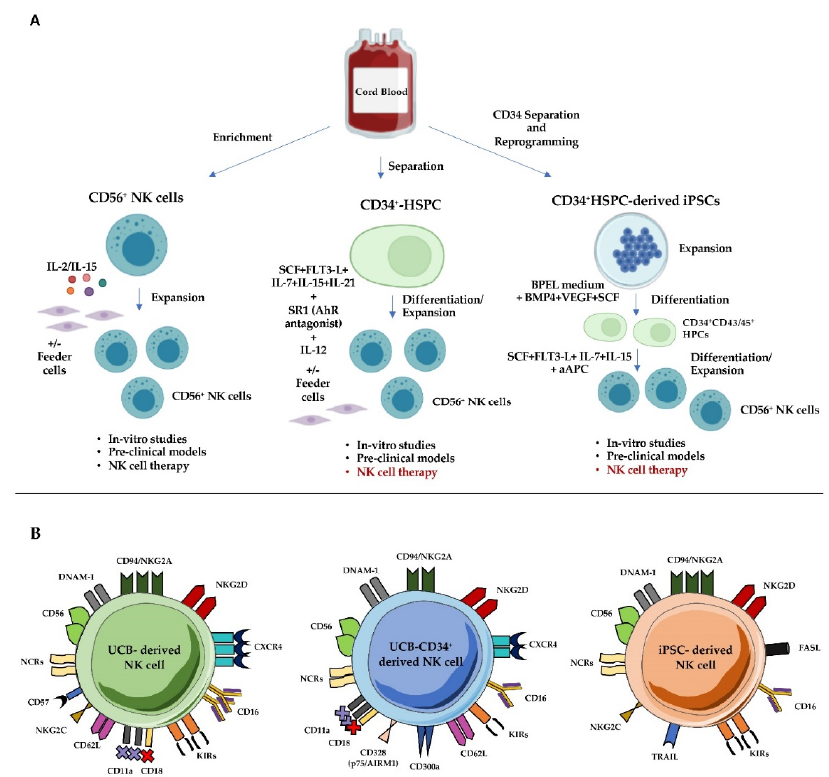
Figure 1. UCB as a source of NK cells. Panel ( A ). Overview of methods to generate, enrich and expand NK cells from UCB. Purified mature NK cells can be obtained directly from UCB and in-vitro expanded in the presence of IL-12 and IL-15 and feeder cells (e.g., K562, 721.221 cell lines). NK cells can also be differentiated from CD34 + HSPCs, previously separated from UCB, using appropriate cytokine cocktails including SCF, FLT-3L, IL-7, IL-15, IL-21, StemRegenin-1(SR1) antagonist and IL-12 added at a later time. In some instances, feeder cells can also be used (e.g., OP9 cell line). Finally, NK cells can be generated from UCB CD34 + HSPC-derived iPSC. iPSCs are firstly induced to differentiate towards CD34 + CD43 + /CD45 + HPCs by using BPEL medium and BMP4, VEGF and SCF factors. HPCs are then differentiated towards NK cells with SCF, FLT-3L, IL-7 and IL-15 cytokines and further expanded with aAPCs. All UCB-derived CD56 + NK cells are used for in-vitro studies and in preclinical models while at present, UCB-derived mature NK cells are the most exploited source for adoptive cell therapy against hematological and solid tumors. In the HSCT setting, CD34 + HSC are responsible for the in-vivo generation of NK cells. Panel ( B ). Comparison of UCB-derived NK cells phenotype. Left: UCB-derived mature NK cells; center: CD34 + HSPC-derived NK cells; right: iPSC-derived NK cells. All types of UCB-derived NK cell express the same levels of CD56, NCRs (NKp46, NKp44 and NKp30), NKG2D and DNAM-1 molecules but UCB-mature NK cells and iPSC-derived NK cells show higher expression of NKG2A and KIRs as compared to UCB- CD34 + derived NK cells. UCB-CD34 + derived-and iPSC-derived-NK cells express lower amounts of CD16 receptor as compared to UCB-derived mature NK cells. Notably, the expression of memory marker NKG2C on UCB-derived mature NK cells and on iPSC-derived NK cells may activate NK cell degranulation and cytokine production. UCB-derived mature NK cells and UCB-CD34 + derived NK cells exhibit higher levels of adhesion molecules such as the heterodimer CD11a/CD18, (LFA-1), and CD62L as compared to iPSC-derived NK cells. The expression of CXCR4 receptor on UCB-CD34 + derived NK cell and on UCB-derived mature NK cell could be crucial for homing in the bone marrow. Finally, the expression of TRAIL and FASL on iPSC-derived NK cell could have a pivotal role to activate tumor cell apoptosis. Illustration also created using BioRender.com (accessed on date: 9 August